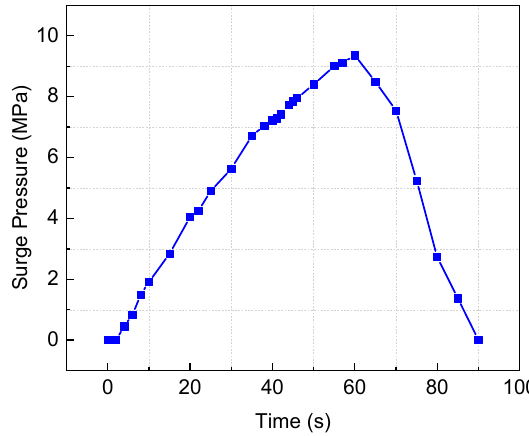
Figure 9. Surge pressure vs. time.